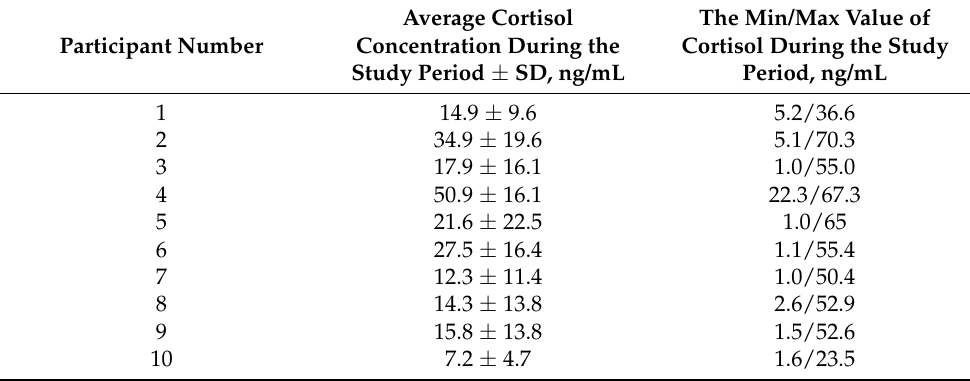
Table 1. Average salivary cortisol concentrations for each study participant over the study